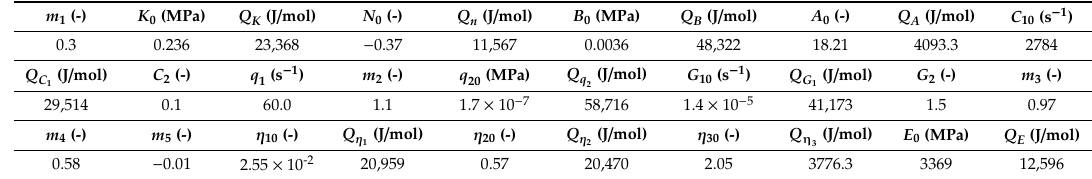
Table 5. Material constants in the developed model for hot